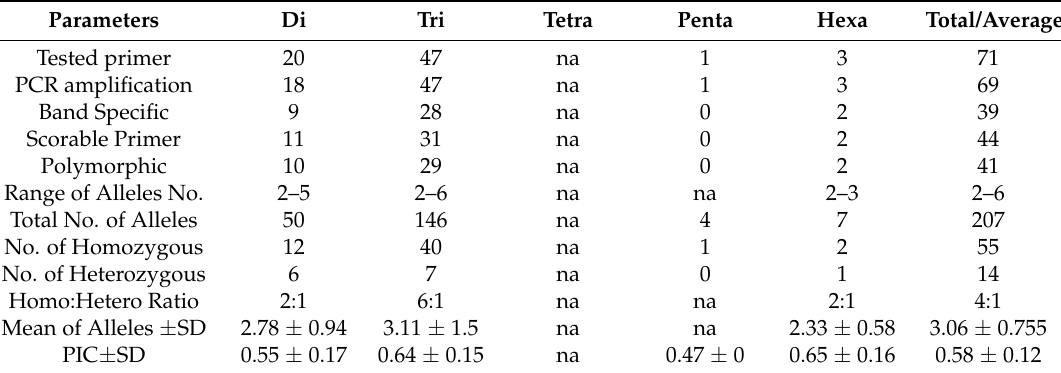
Table 2. Evaluation of TFSSR primer pairs for the different repeat classes (based on 8 genotypes).